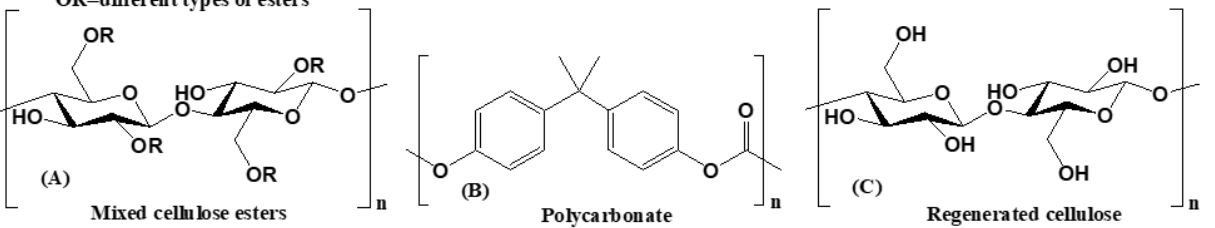
Figure 2. The chemical structure of the membranes: ( A ) Metricel ® , ( B ) Isopore™, and ( C ) Whatman™.